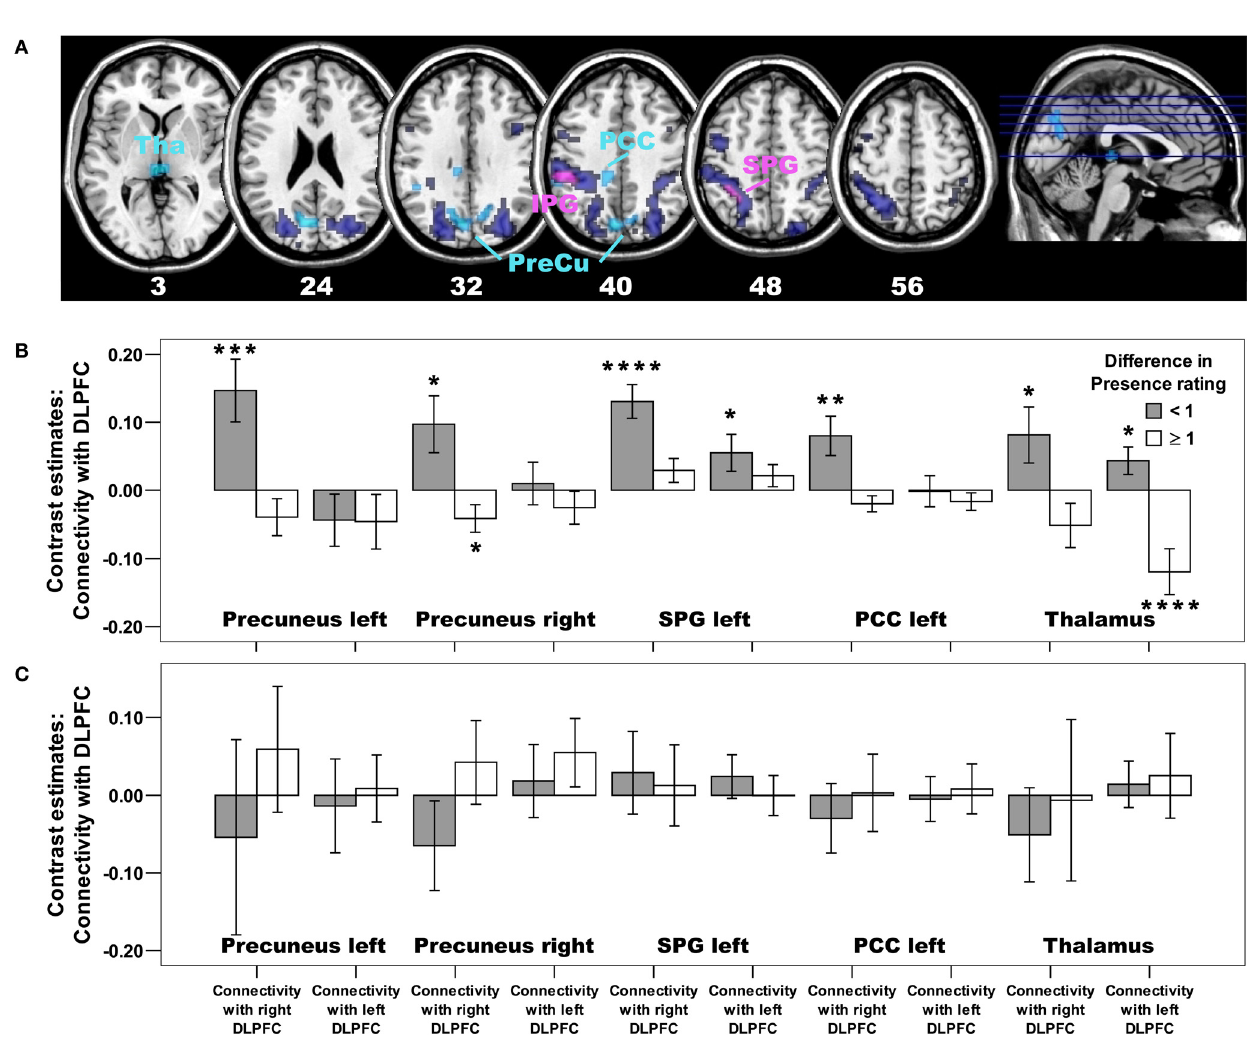
Figure 5 | Negative connectivity differences in adults: Low Presence rating group > High Presence rating group. (A) Whereas all adults, irrespective of their presence rating, used their right DLPFC to down-regulate activation in the dorsal visual stream and sensory-motor areas (depicted in dark blue colour, the same activation as in Figure 3A), subjects of the low Presence rating group used their right DLPFC to down-regulate additional areas of this dorsal visual system (including bilateral precuneus, inferior and superior parietal gyrus) as well as the posterior thalamus (depicted in light blue colour; p < 0.005, cluster extent: 10 voxels; PreCu, Precuneus; IPG, inferior parietal gyrus; SPG, superior parietal gyrus; PCC, posterior cingulate cortex; Tha, Thalamus). Areas in violet colour are down-regulated by all adult subjects, but subjects of the low Presence rating group showed an even stronger down-regulation in this part of the inferior and superior parietal cortex. For those regions showing a differential group effect depicted in (A) , we also created regions of interests and extracted Beta estimates. Bar plots based on these Beta estimates are depicted for (B) adults and (C) children, broken down for the low (Difference in Presence rating < 1) and high (Difference in Presence rating ≥ 1) Presence rating groups. Positive values indicate negative connectivity, whereas negative values indicate positive connectivity. Asterisk indicate signifi cant increase in negative or positive connectivity at p < 0.05 ( * ), p ≤ 0.01 ( ** ), p ≤ 0.005 ( *** ), or p ≤ 0.001 ( **** ). The bar plots in (B) illustrate that, except for the thalamus, an unilateral, right-sided and negative connectivity pattern has been observed in adult subjects of the low Presence rating group. In contrast, children of the low Presence rating group did not show this negative connectivity pattern in any brain region of the dorsal visual stream, either with the right or left DLPFC [depicted in (C) , see Table S12 for detailed statistical